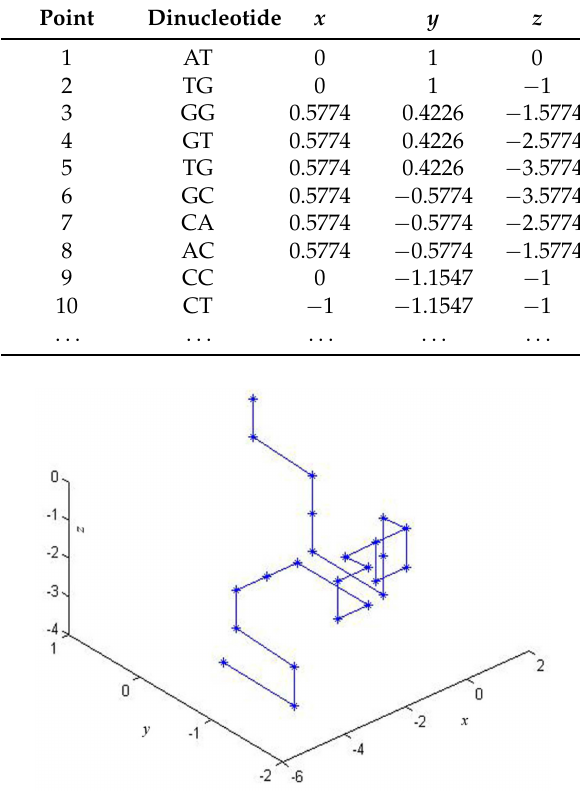
Figure 1. 3-D graphical representation of the sequence